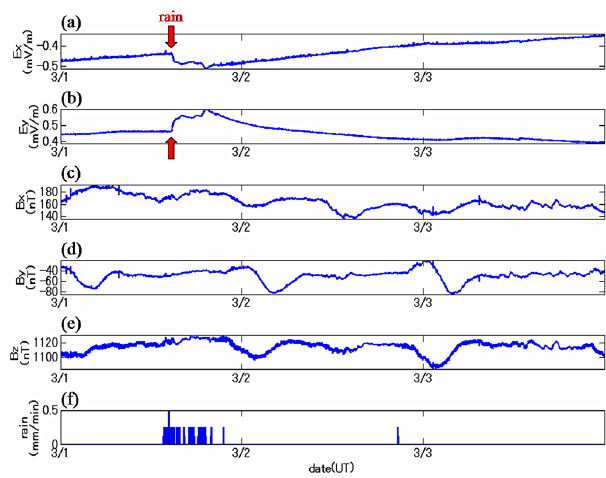
Fig. 2. An example of ULF electromagnetic variation associated with precipitation. (a) Ex component (mVm − 1 ), (b) Ey component (mVm − 1 ), (c) Bx component (nT), (d) By component (nT), (e) Bz component (nT), and (f) precipitation.